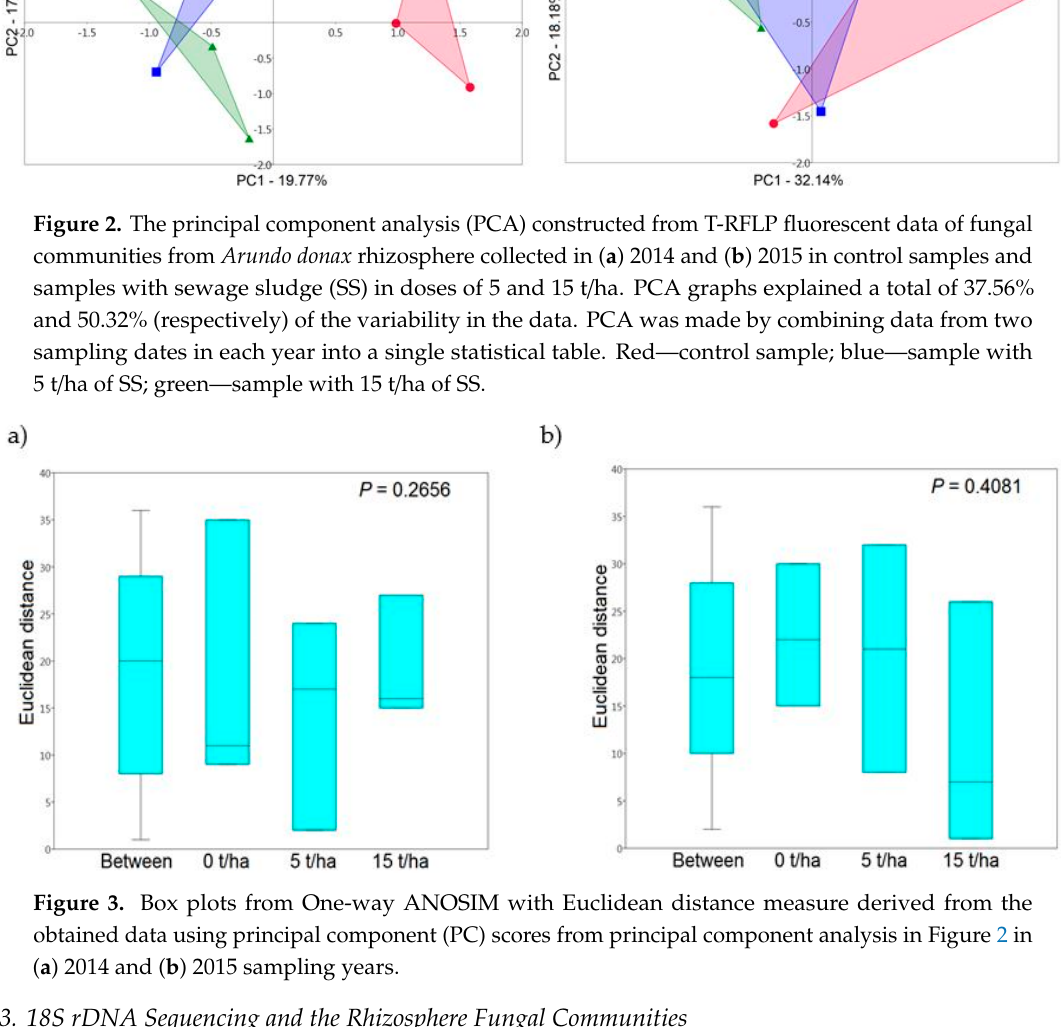
Table 4. Comparison of sequenced clones from the rhizosphere of Arundo donax without SS in the soil with 18S rDNA sequences of fungi with the highest similarity using Nucleotide BLAST.